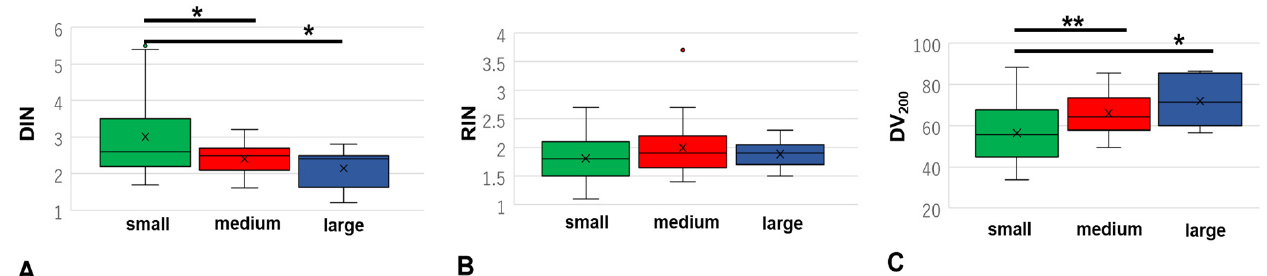
Figure 4. The relationships of DIN ( A ), RIN ( B ), and DV 200 ( C ) relative to the sample volume: small ( ≤ 12 × 12 mm), large ( ≥ 24 × 24 mm), and medium (with dimensions other than those of the small and large groups) in SC and DLBCL samples. DIN, DNA integrity number; RIN, RNA integrity number; SC, small cell lung carcinoma; DLBCL, di ff use large-B-cell lymphoma (*, p < 0.05; **, p < 0.01).